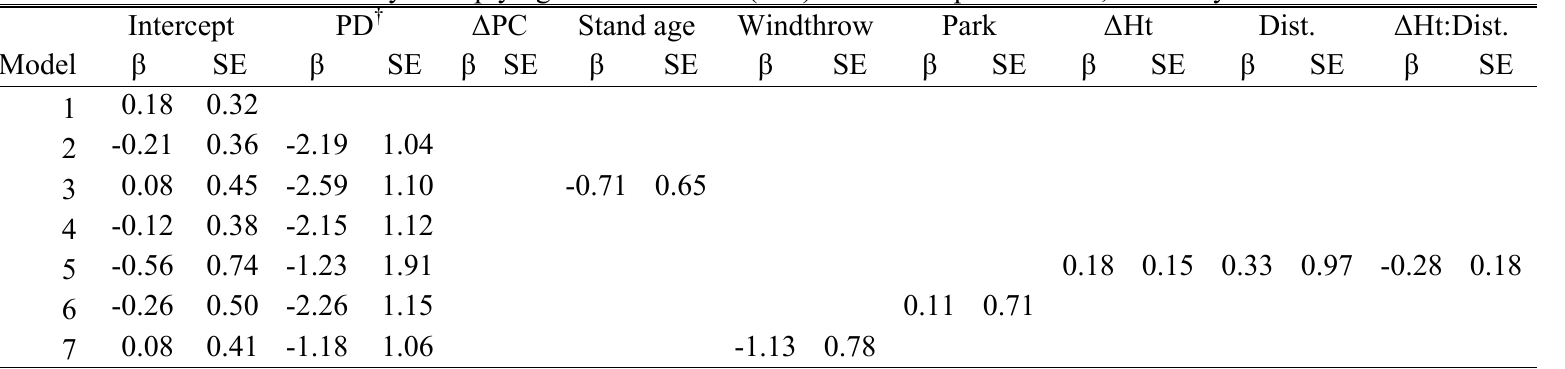
Table A2.4 Parameter estimates for models examining variation in stand-level trends (between circa 1994 and 2014) in abundance Hermit Thrush in aspen dominated mixedwood forests in central Saskatchewan. 85% Confidence Intervals can be obtained as β ± 1.44* SE. NOTE: Parameter values were rescaled by multiplying with a constant (100) for ease of presentation, divide by 100 to obtain estimates.